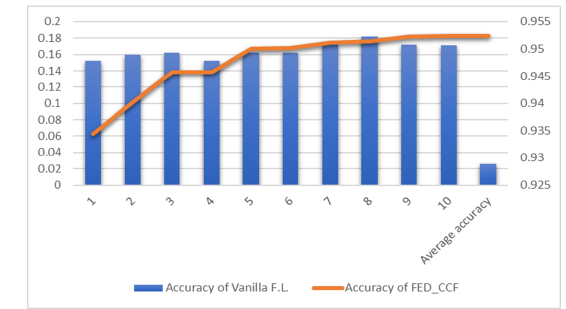
Fig. 6. Average accuracy of FED_CCF and Vanilla F.L.